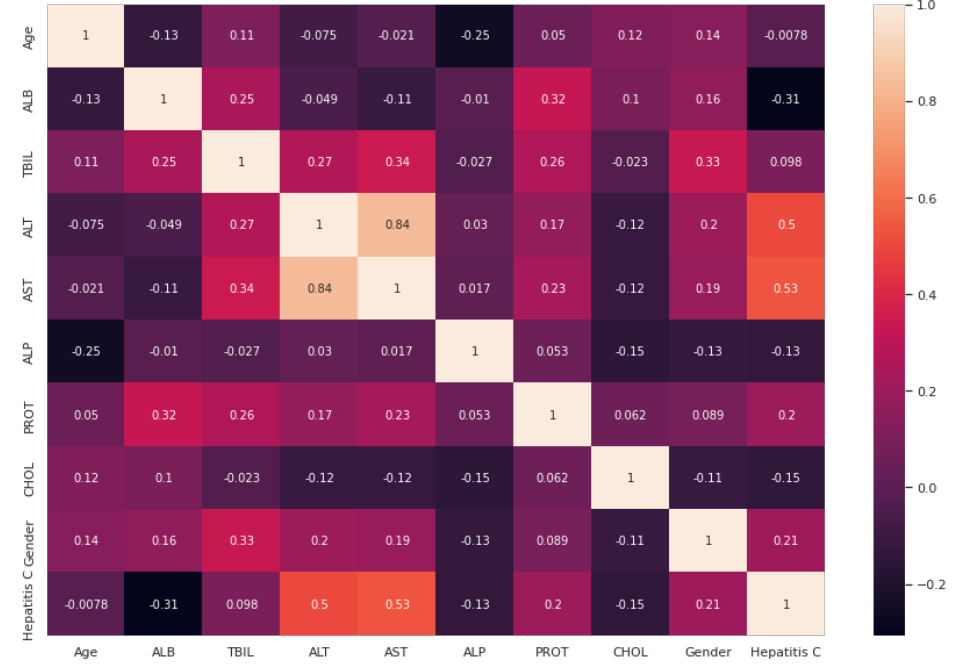
Figure 2. Heat map for the relation between different attributes based on the NHANES dataset.